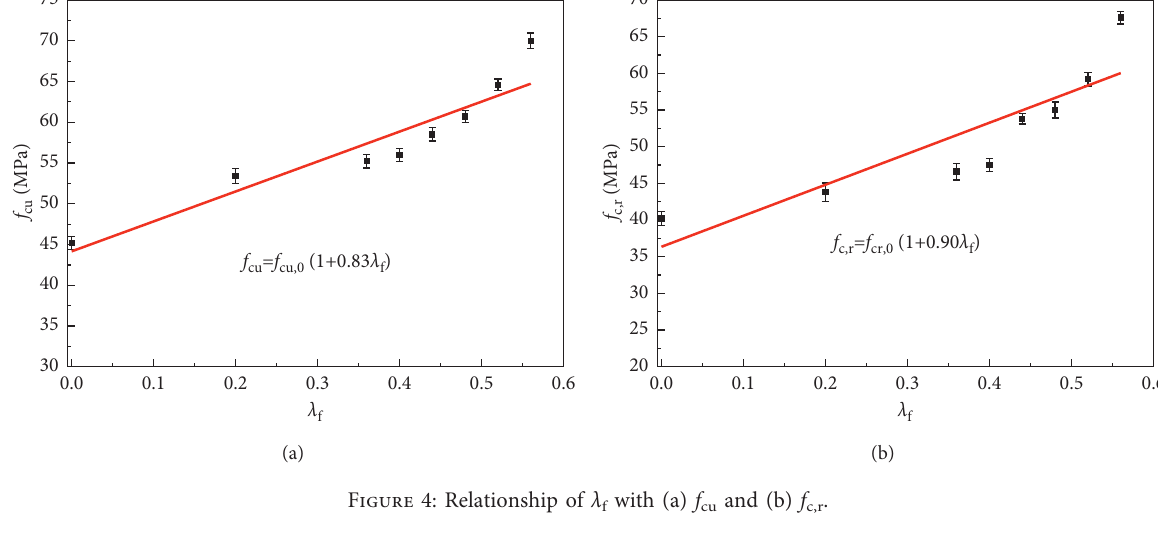
f with (a) f cu and (b) f c,r